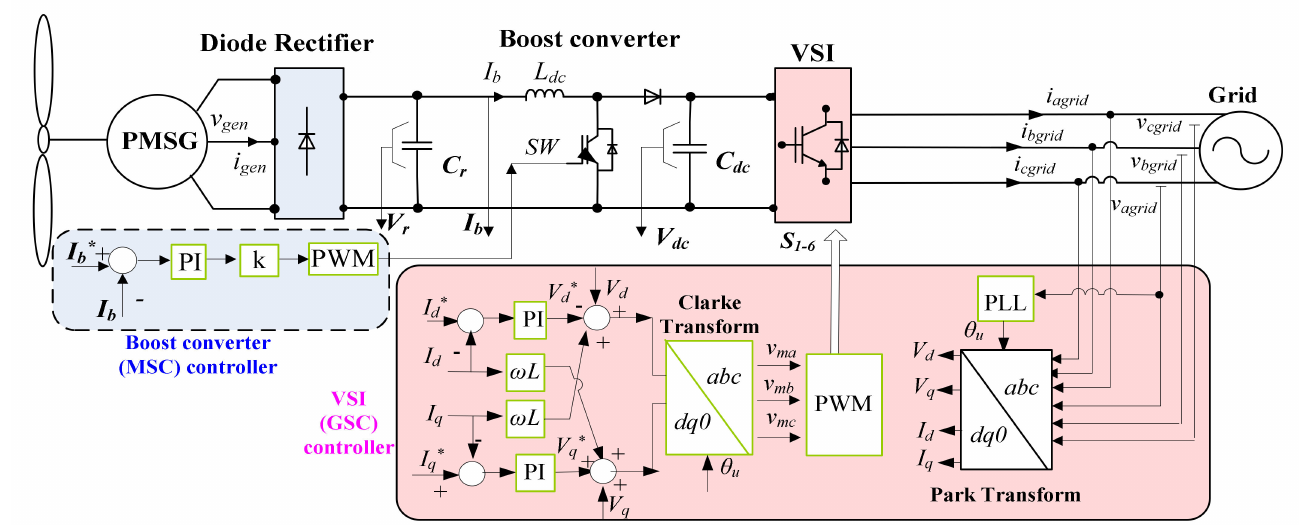
Figure 5. MSC and GSC controllers for the considered PMSG WECS.